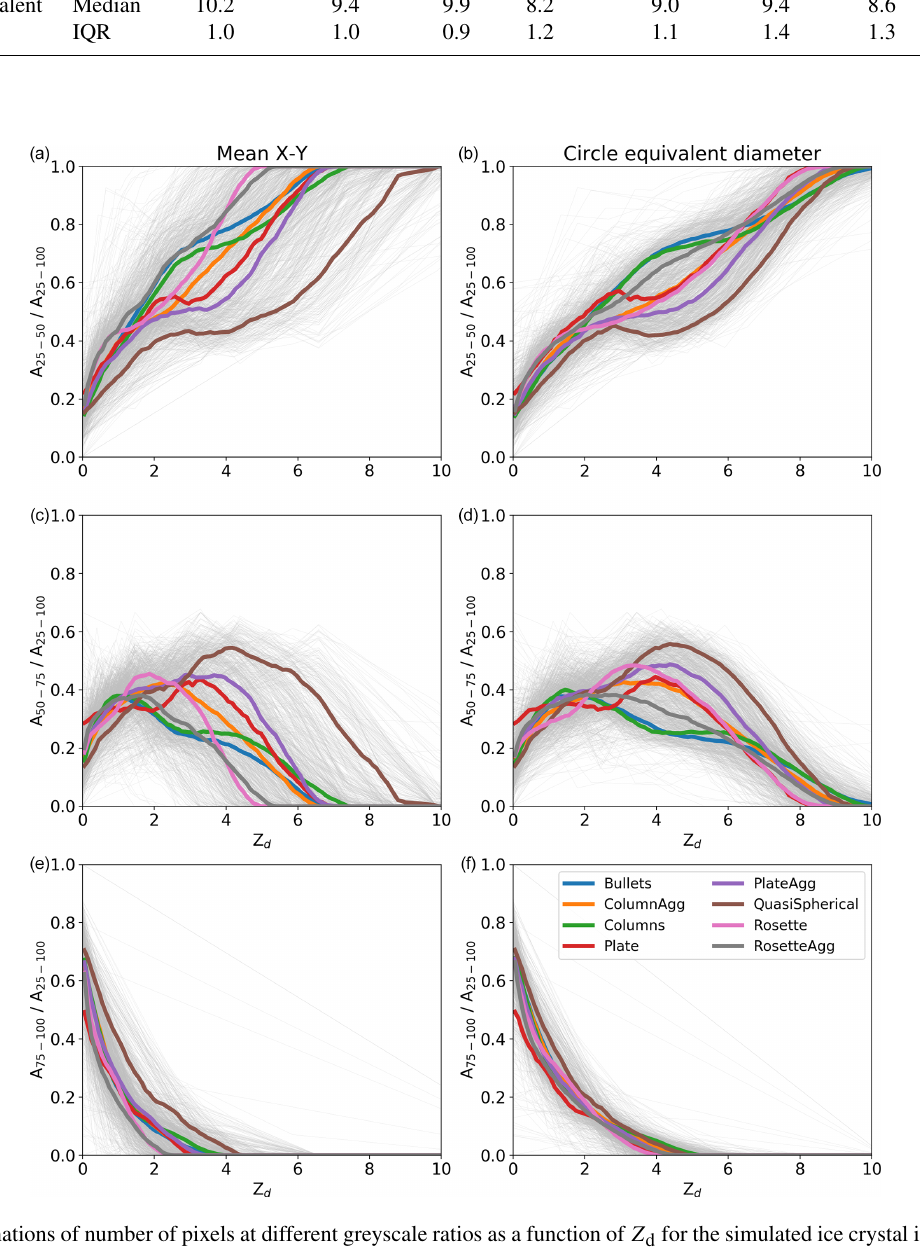
Figure 10. Combinations of number of pixels at different greyscale ratios as a function of Z d for the simulated ice crystal images. Panels (a) , (c) , and (e) show plots where mean X – Y is used as the sizing metric, while panels (b) , (d) , and (f) use circle equivalent